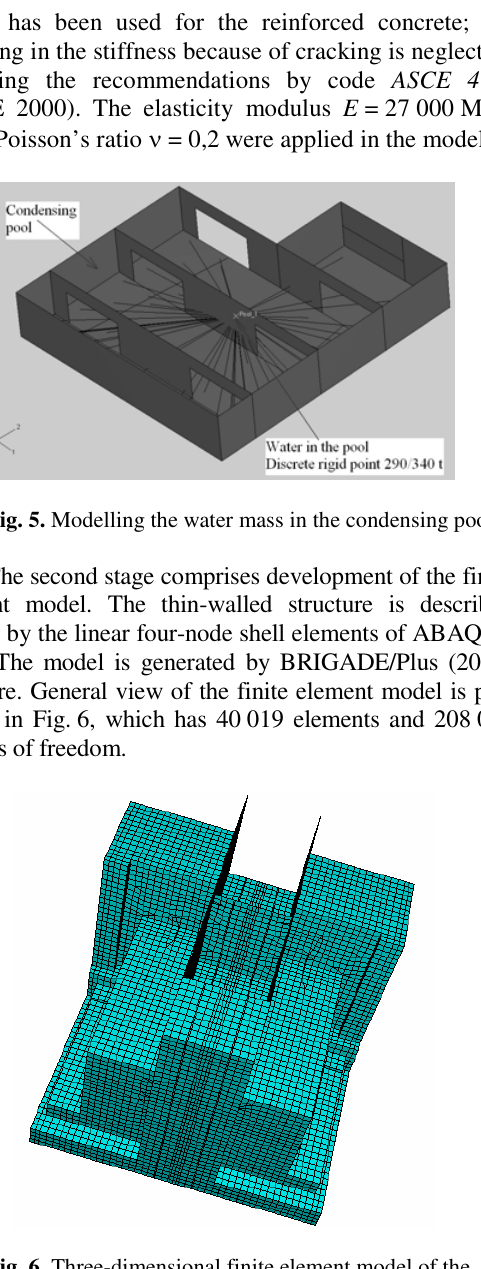
Fig. 6. Three-dimensional finite element model of the INPP reactor building